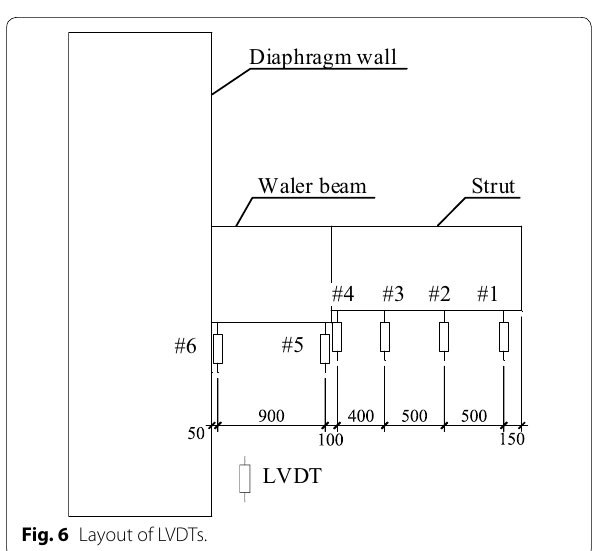
Fig. 6 Layout of